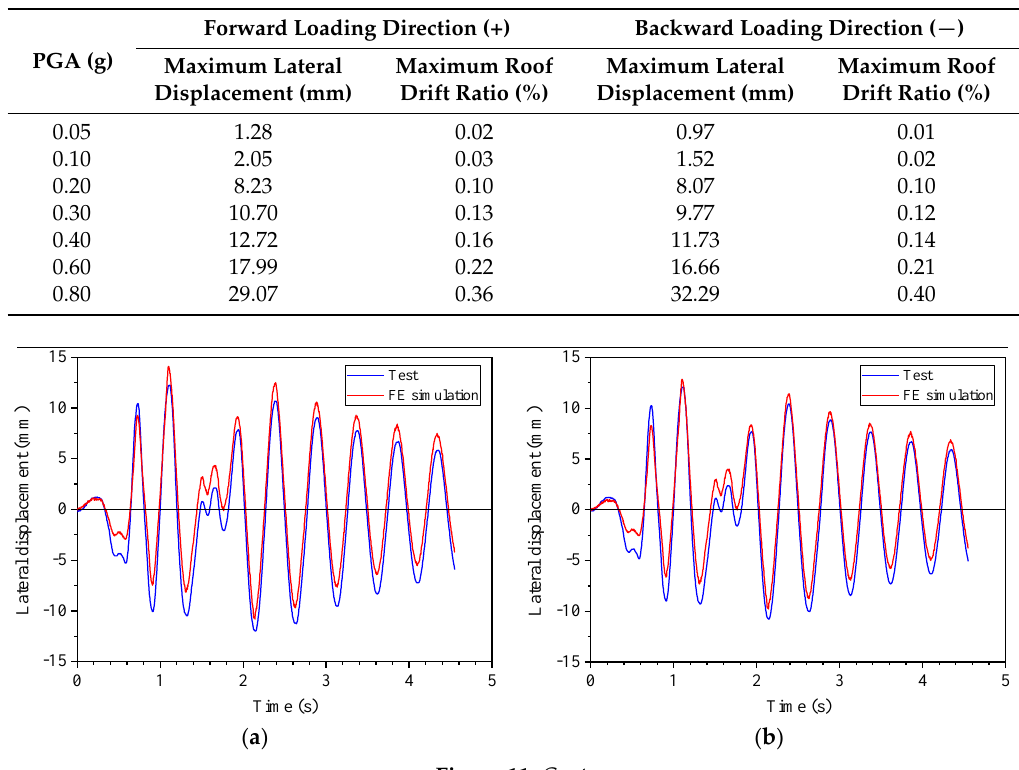
Table 4. Test results of maximum lateral displacements and drift ratios on the top of A-shaped frame.